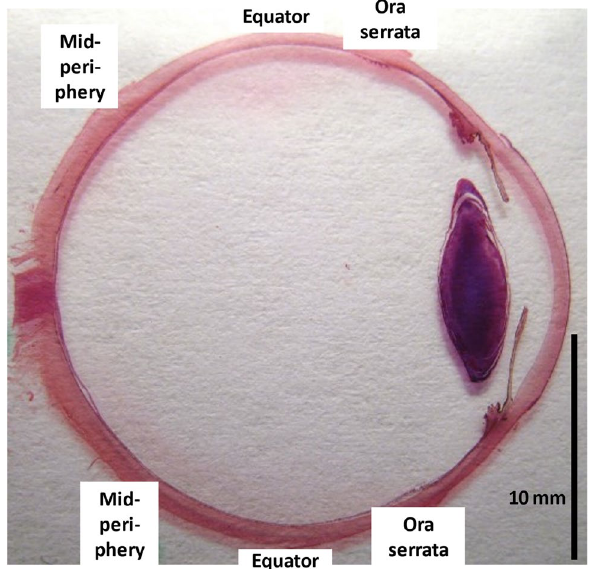
Figure 1. Globe shoring the measurement